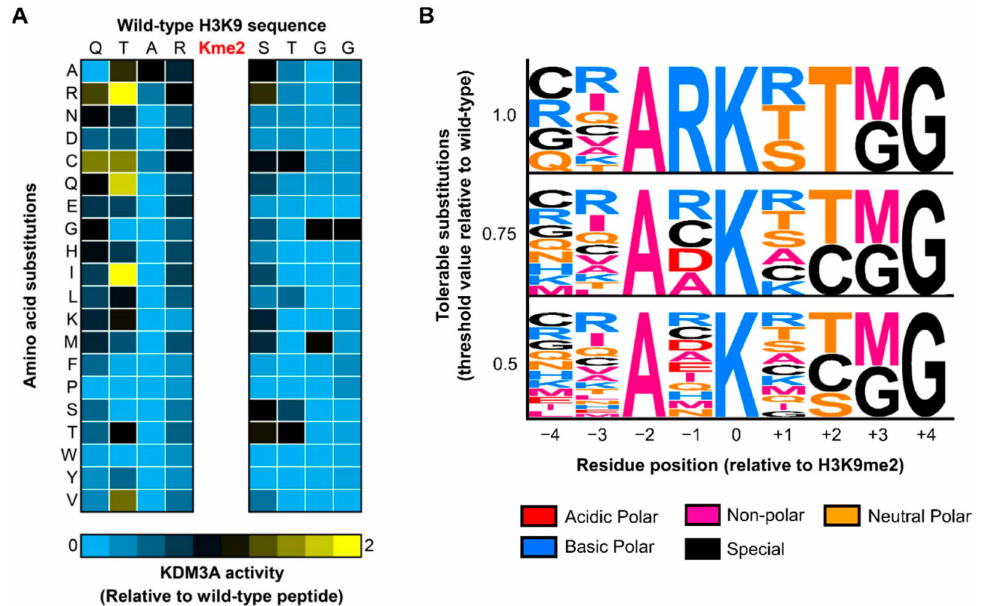
Figure 3. Substrate specificity profile of KDM3A towards H3 2-16 -K9me2 permutation library. ( A ) Activity of 600 nM KDM3A was assessed towards 10 µ M of H3 2-16 -K9me2 WT or